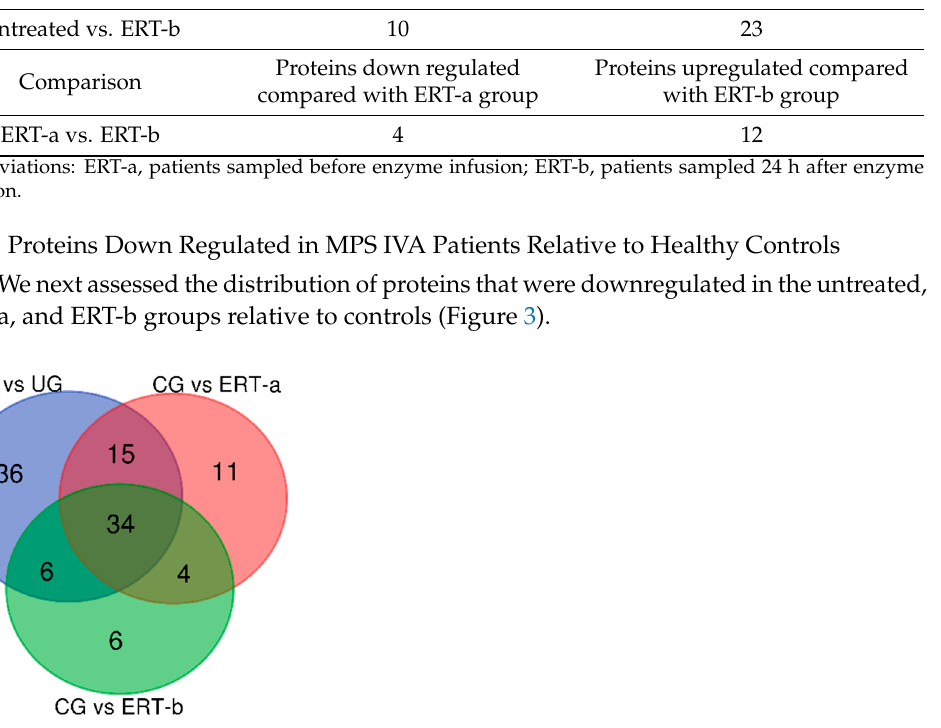
Figure 3. Venn diagram showing the distribution of leukocyte proteins that were downregulated the untreated, ERT-a, and ERT-b groups relative to healthy controls. Abbreviations: CG, control group; UG, untreated group; ERT-a, patients sampled before enzyme infusion; ERT-b, patients sampled 24 h after enzyme infusion.